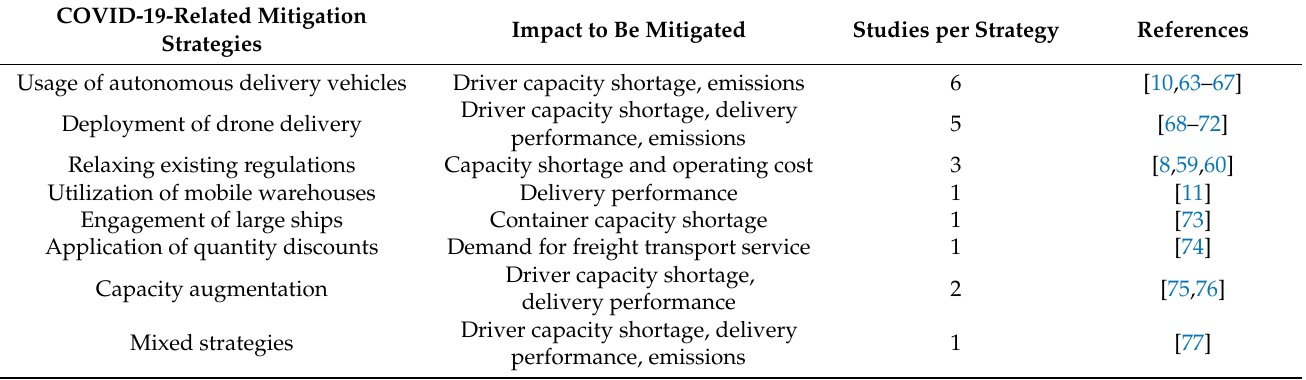
Table 7. Mitigation strategies for minimizing the impact of